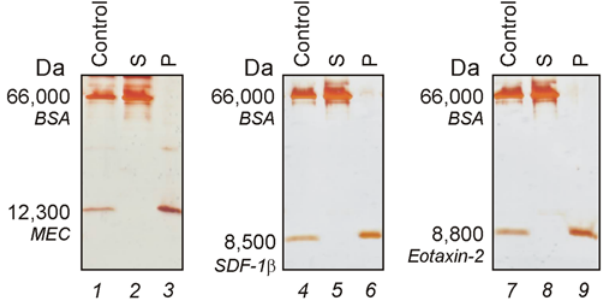
Figure 8. SDS PAGE analysis showing chemokines uptake by particles. Core-shell particles were incubated with the following chemokines, mucosae-associated epithelial chemokine (MEC/CCL28), stromal cell-derived factor-1 beta, (SDF-1 b /CXCL12b), and eotaxin-2 (CCL24), in presence of bovine serum albumin (BSA). Solutions of the chemokines and BSA are shown in lanes 1, 4, and 7. After incubation with the particles, no chemokine was left in the supernatant (S, lane 2, 5, and 8) and all the chemokine was captured by particles (P, lanes 3, 6, and 9). BSA was totally excluded by particles.